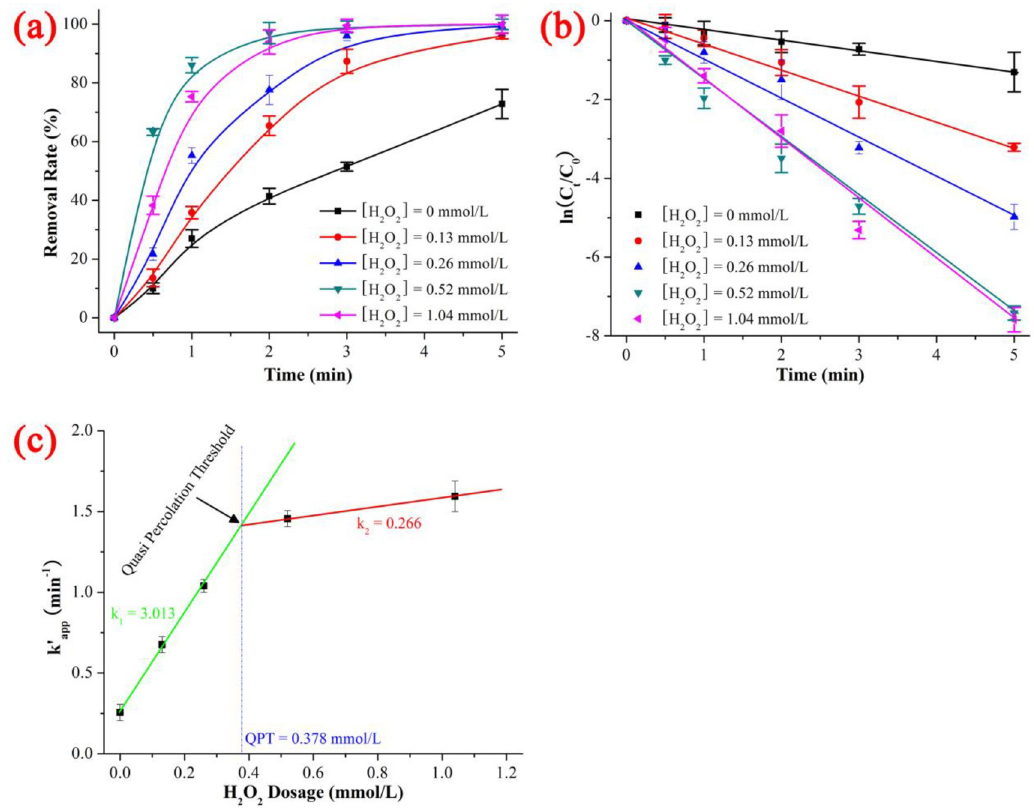
Fig 3. Effect of H 2 O 2 dose on removal rate (a), kinetics constant (b) and linear fitting between kinetics constant and H 2 O 2 dose on the degradation of NIF via UV/H 2 O 2 . The error bars represent the standard deviation (n = 3).